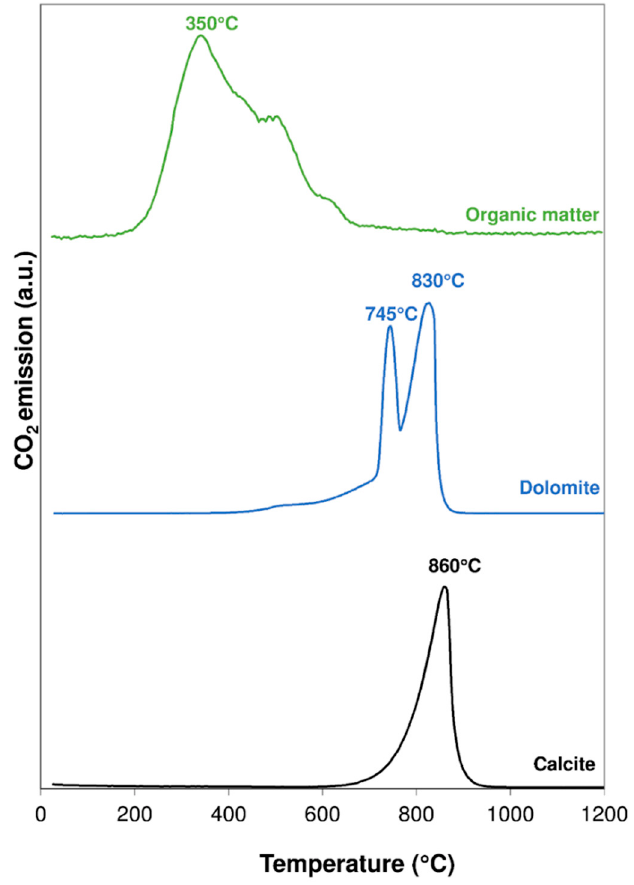
Figure 1. CO 2 emission evolution of analyzed samples.